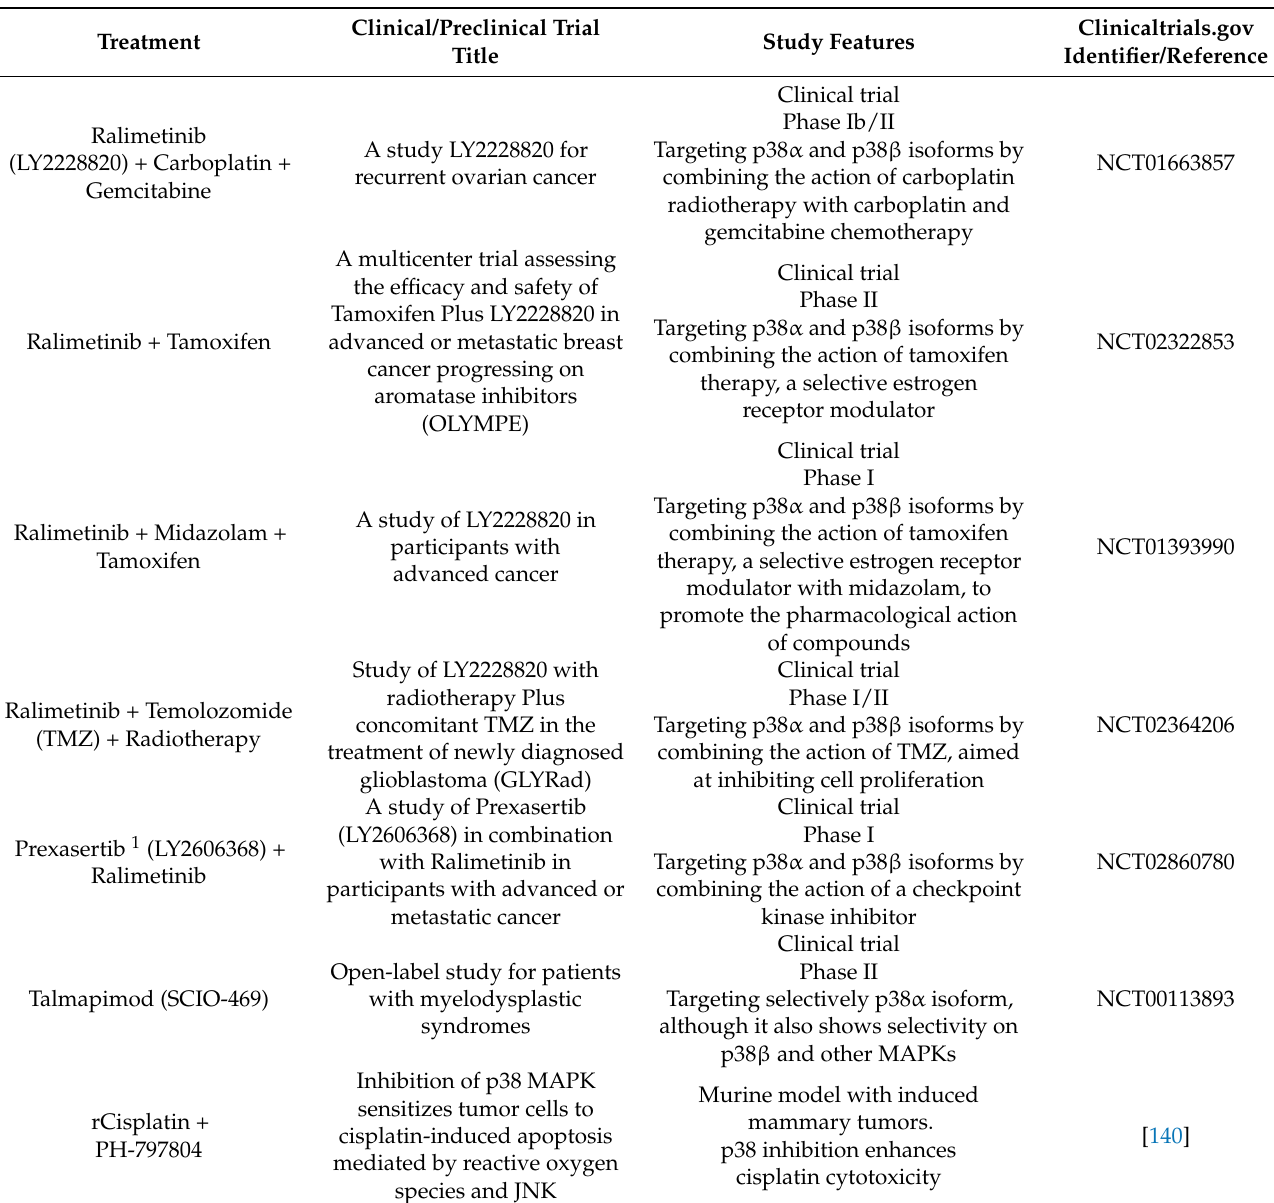
Table 1. Preclinical and clinical trials in recent years aimed at testing inhibitors targeting components of the p38 MAPK pathway as cancer